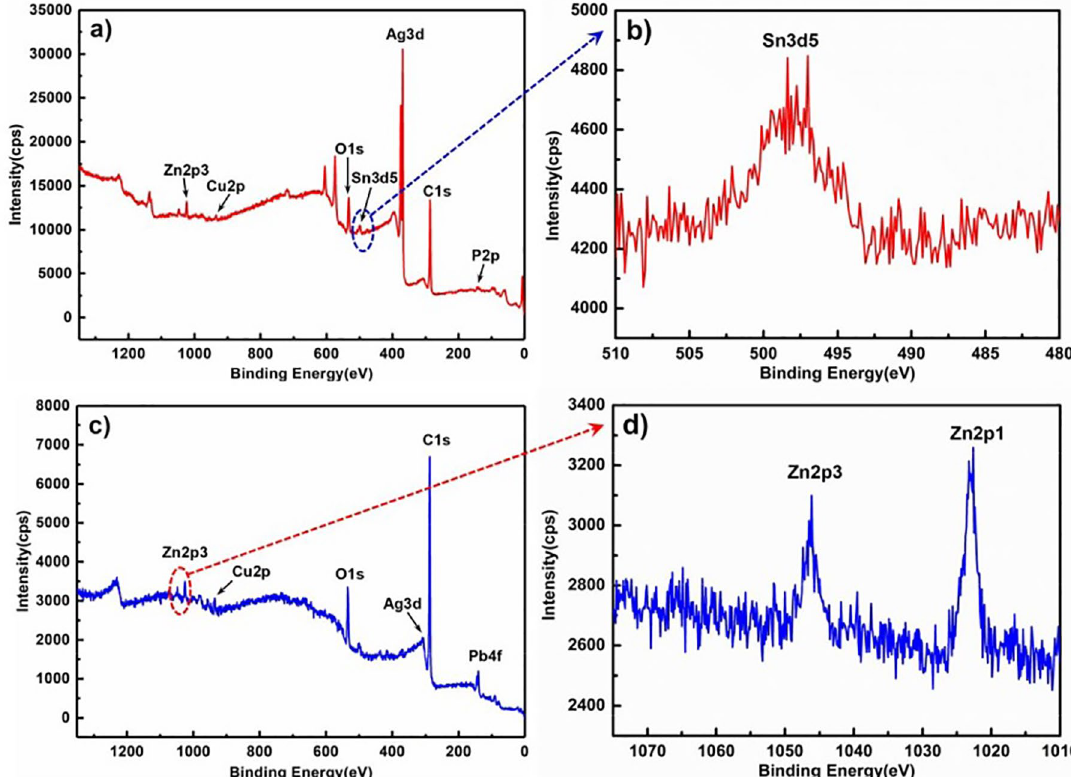
alloy after 10,000 times switching, and surface 2 alloy after 3,000 times 2